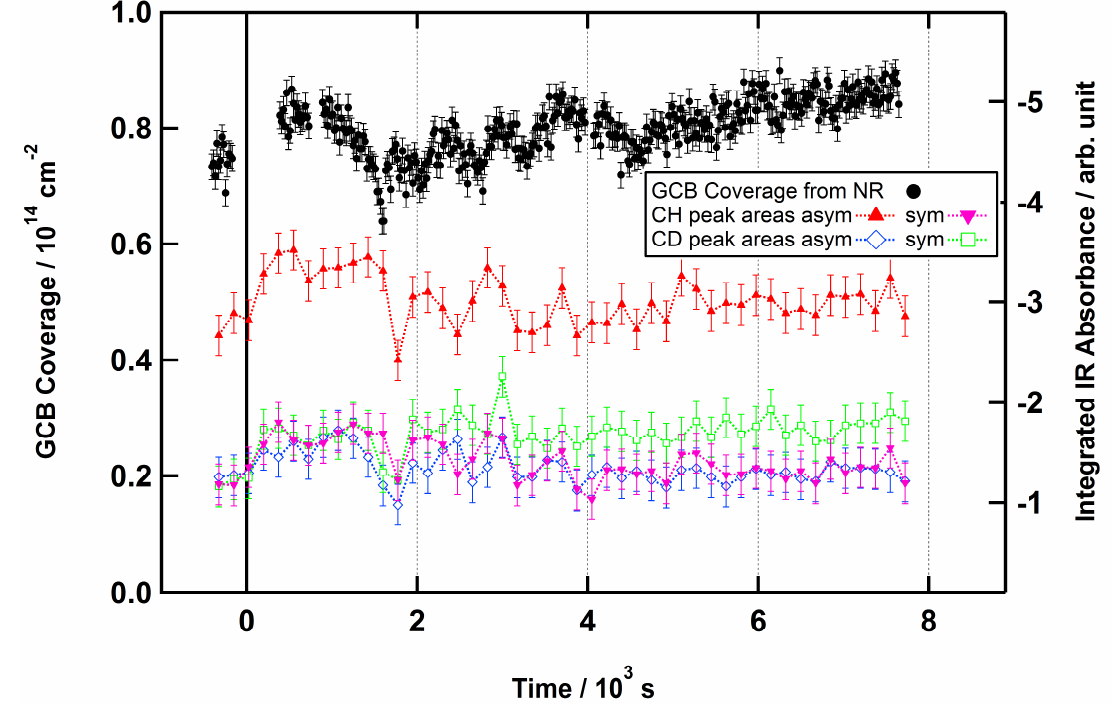
Figure 8. Oxidation of a two component (GCB/PA) monolayer on CaCl 2 aqueous solution—NR (black circles and left ordinate) and IRRAS (coloured symbols and right ordinate) data as a function of time. We spread a monolayer of ~6.5 × 10 − 5 L from a spreading solution containing ~0.5 g L − 1 of d -GCB and ~0.5 g L − 1 of d -PA in CHCl 3 . NO 3 • was admitted at t = 0 s at a concentration of ~4.4 × 10 9 cm − 3 . The integrated absorbance areas for the IRRAS data were calculated for 2110–2070 cm − 1 and 2208–2178 cm − 1 for CD bonds (one symmetric and one asymmetric stretch coloured squares and diamonds) and for 2868–2833 cm − 1 and 2945–2898 cm − 1 for CH bonds (one symmetric and one asymmetric stretch; coloured